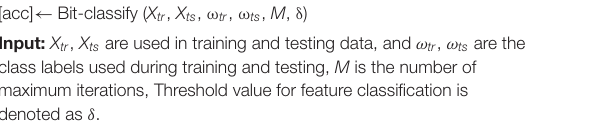
ALGORITHM 1 | Bit-fusion ensemble